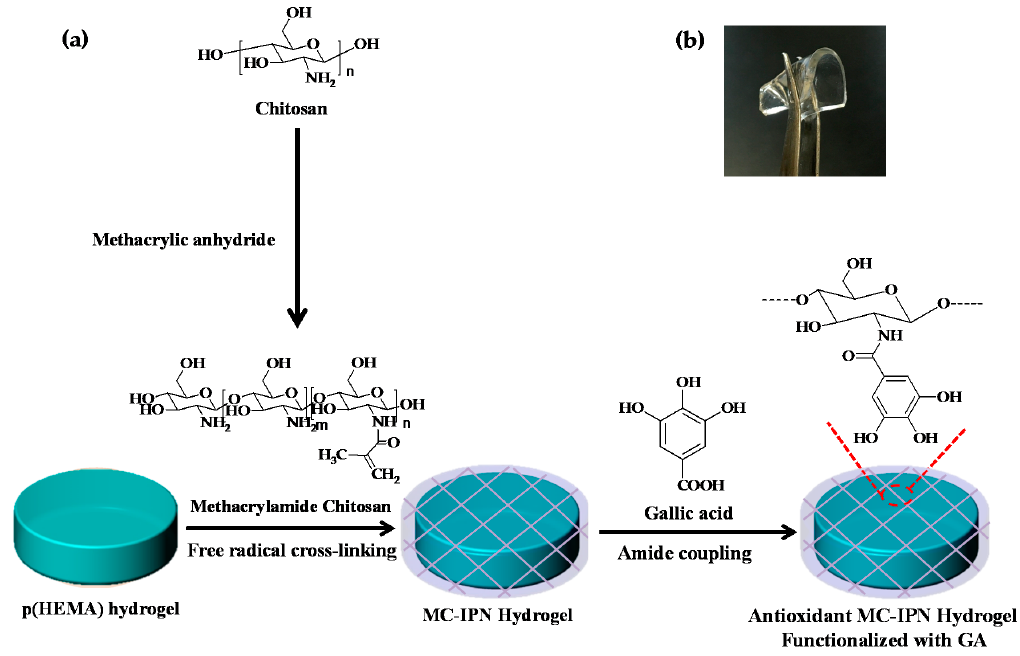
Figure 1. ( a ) Schematic representation for development of chitosan-interpenetrating polymer network (IPN) hydrogels functionalized with polyphenols; ( b ) Photograph of the fabricated antioxidant hydrogel.